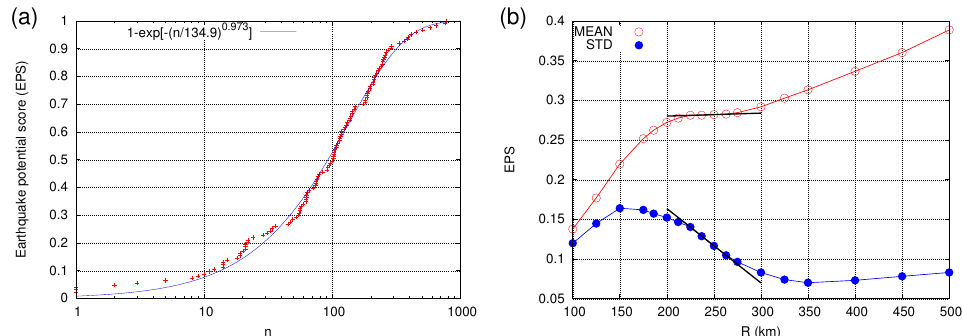
Figure 3. ( a ) The cumulative distribution of the number n of EQs with M ≥ 4.0 that occurred between two EQs of magnitude M ≥ 6.0 in the area N 52 E 50 of Figure 1. The results came from 123 EQ cycles 23 5 after using the Weibull model; see Table 1 of [123]. ( b ) The mean value and the standard deviation of the EPS estimated at the nearest to the epicenter point of a 0.1 ◦ × 0.1 ◦ square degrees grid at the time of the minima are depicted by the (red) open circles in Figure 2 as a function of the coarse grain radius R . The (black) thick straight lines were designed as a guide for the